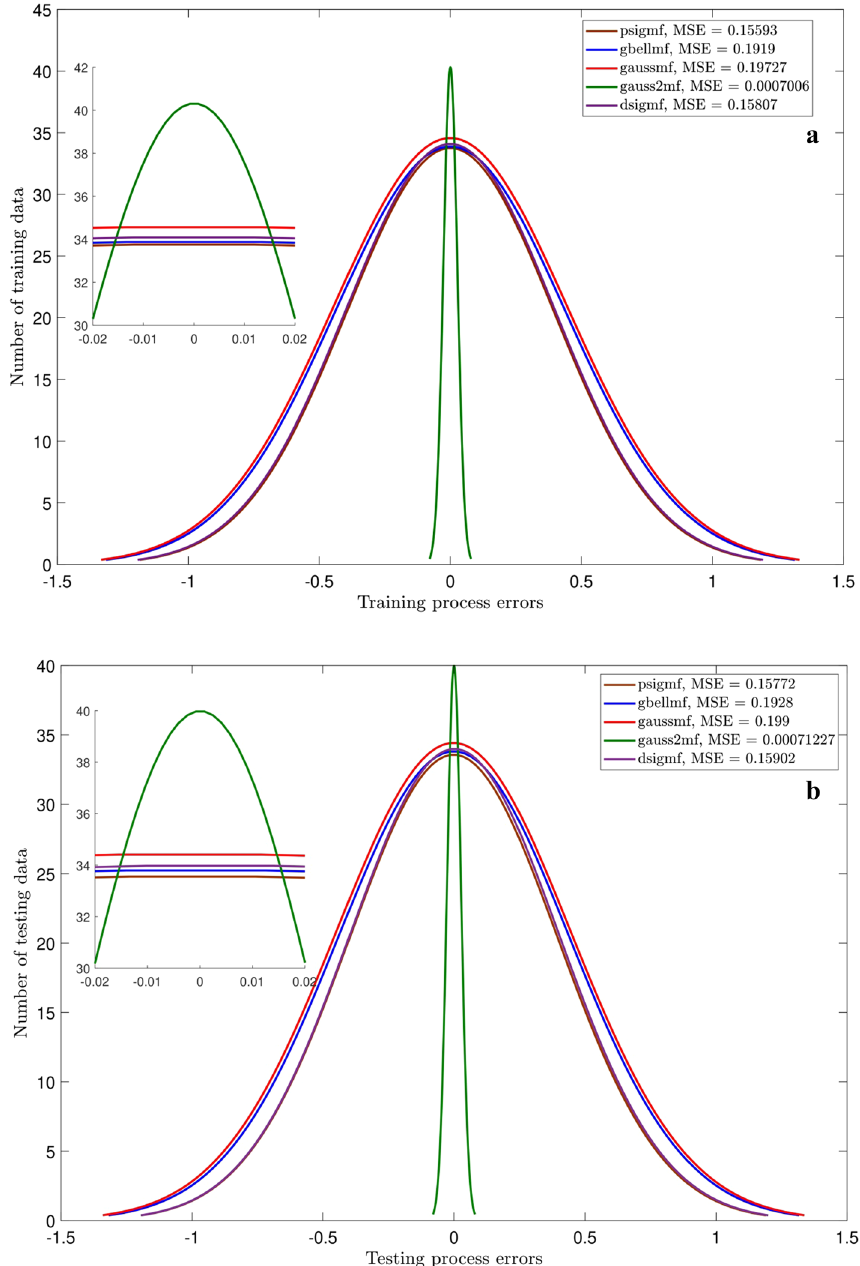
Figure 5. ( a ) Errors of training for different type of membership function when number of inputs is four. ( b ) Errors of testing for different type of membership function when number of inputs is